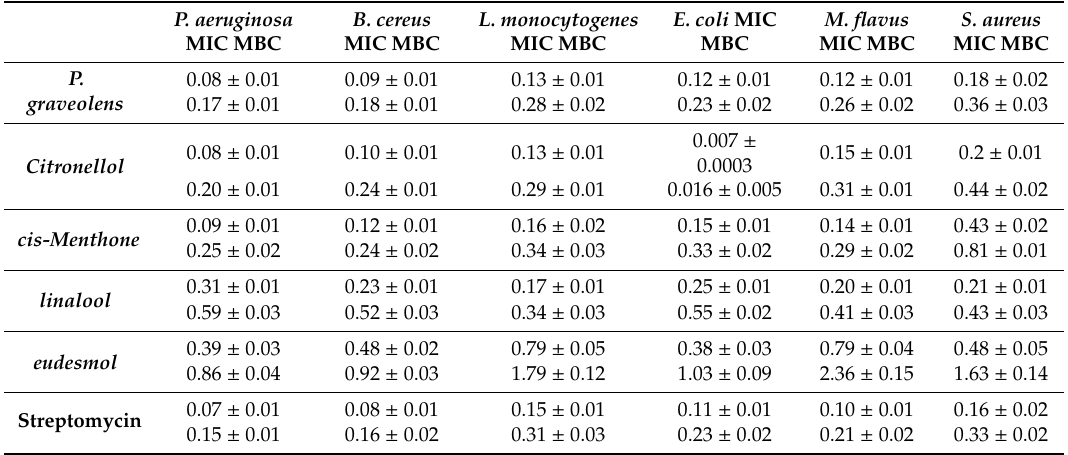
Table 3. Minimum inhibitory (MIC) and bactericidal concentration (MBC) of Pelargonium graveolens leaf extracts (mg mL − 1 ) as well as identified compounds.